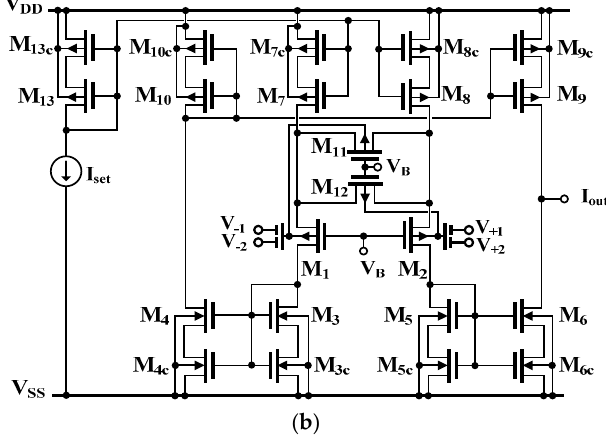
Figure 4. The symbol of the multiple-input G m stage ( a ) and its CMOS structure ( b ).